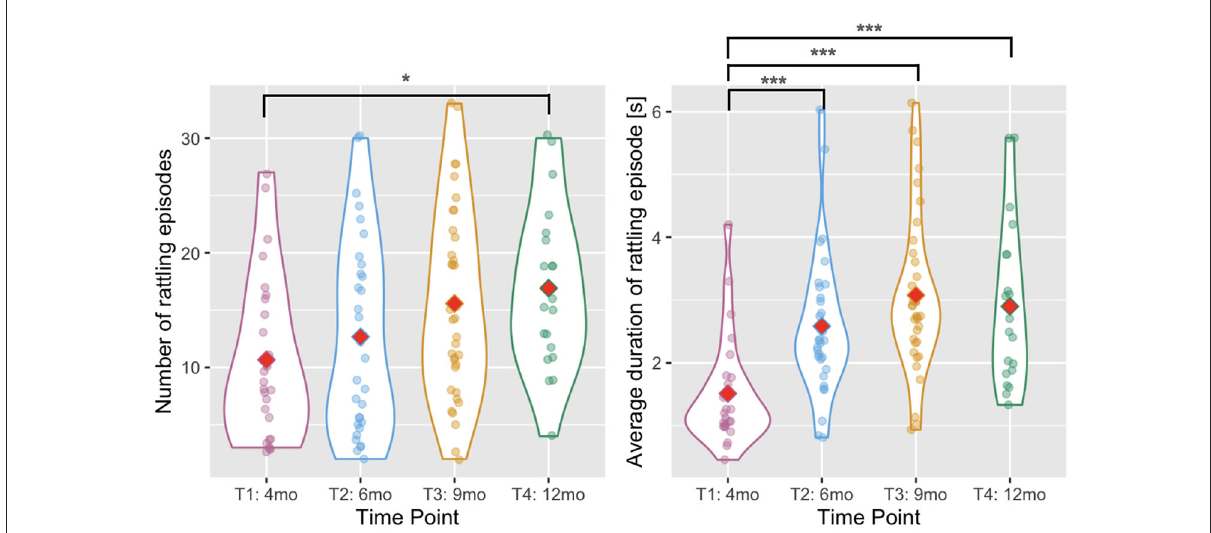
FIGURE3 Violin plots showing the number of rattling episodes (left) and the average duration of rattling episode (right) across time points. Red diamonds indicate mean values. A single asterisk indicates significance at p < 0.05, two asterisks indicate p < 0.01, and three indicate p < 0.001.